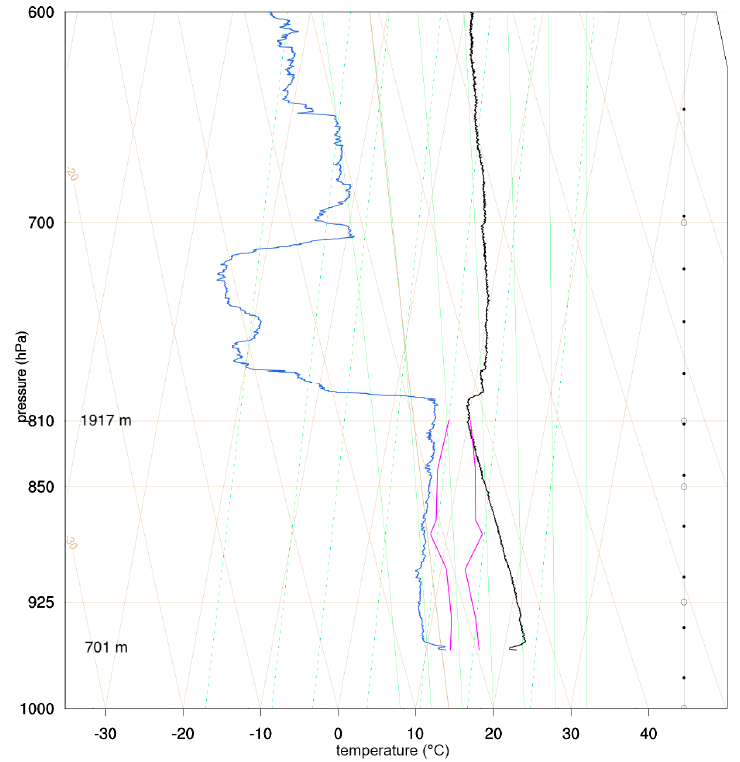
Figure 7. Skew-T diagram of the 1825 EST 19 August 2016 radiosonde profiles of temperature (black line) and dewpoint (blue line). Summit and Auto Road weather station temperature and dewpoint (magenta lines) are shown for comparison. The 810 hPa isobar indicates the summit station pressure on this day.